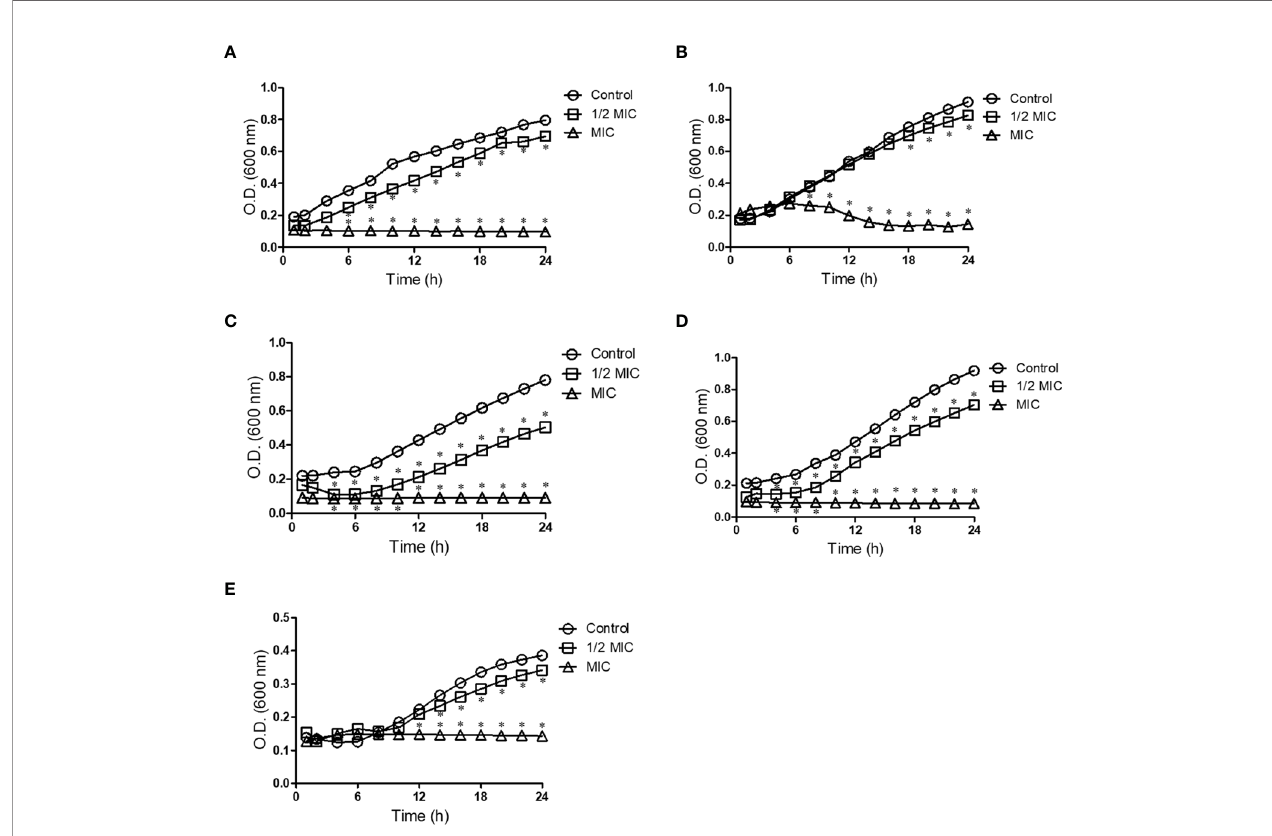
FIGURE 1 | Kinetic growth of Scedosporium aurantiacum (A) , Scedosporium boydii (B) , Scedosporium apiospermum (C) , Scedosporium dehoogii (D) and Lomentospora proli fi cans (E) . Cells were incubated in the absence or the presence of different concentrations of miltefosine at 37°C for up to 24 h; the optical density was measured every 2 h. * p <